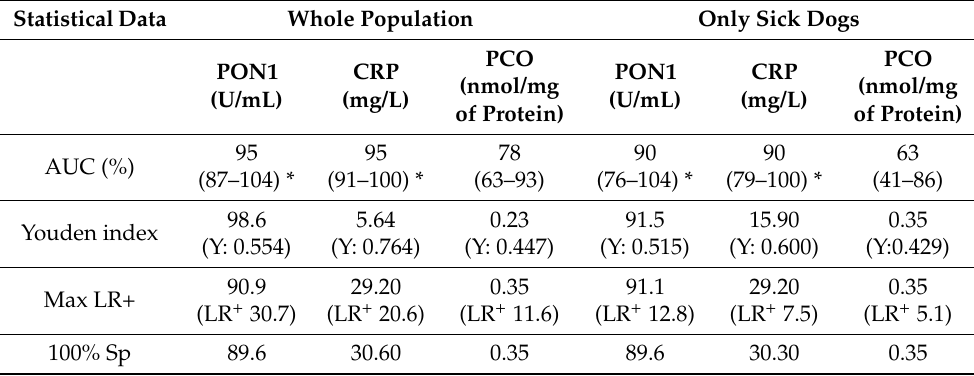
Figure 3. Comparison of ROC curves to support a diagnosis of sepsis designed for PCO (black circles, continuous line), CRP (black triangles, dotted line) and PON1 (black squares, dashed line). The graph on the left ( A ) includes the results of the three groups of dogs, the graph on the right ( B ) includes only the results of dogs with sepsis or trauma. The grey line indicates the line of no discrimination. TPF = true positive fraction; FPF = false positive fraction. Table 2. Area under the ROC curves (AUCs), Youden index and operating points characterized by the highest LR+ and by absolute specificity for PON1, CRP and PCO to support a diagnosis of sepsis, calculated either including or excluding clinically healthy dogs from the